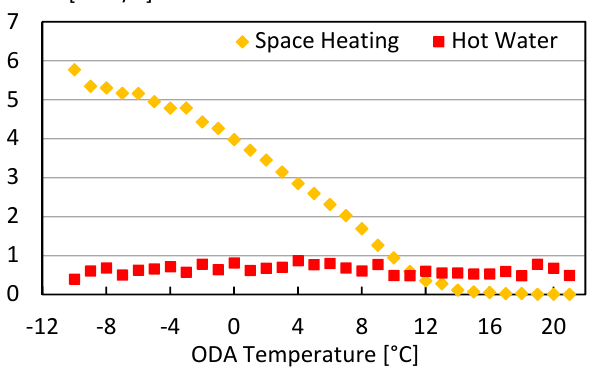
Figure 14. Measured building energy signature for 2014–2016.